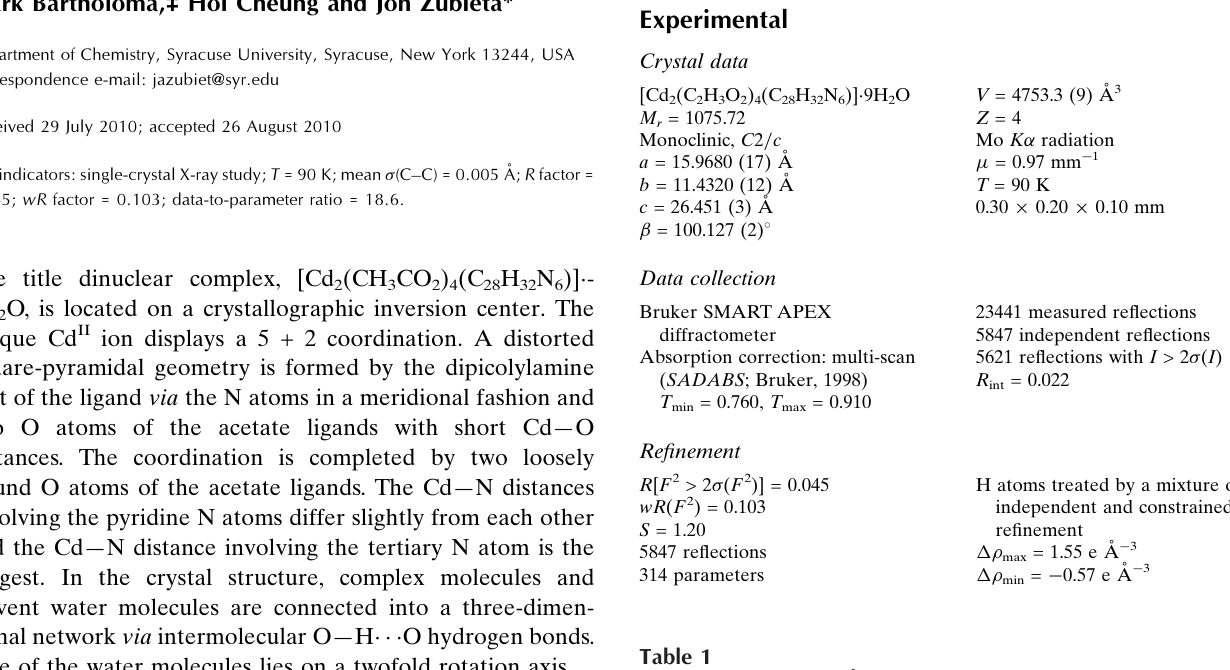
Selected bond lengths (A˚ ).